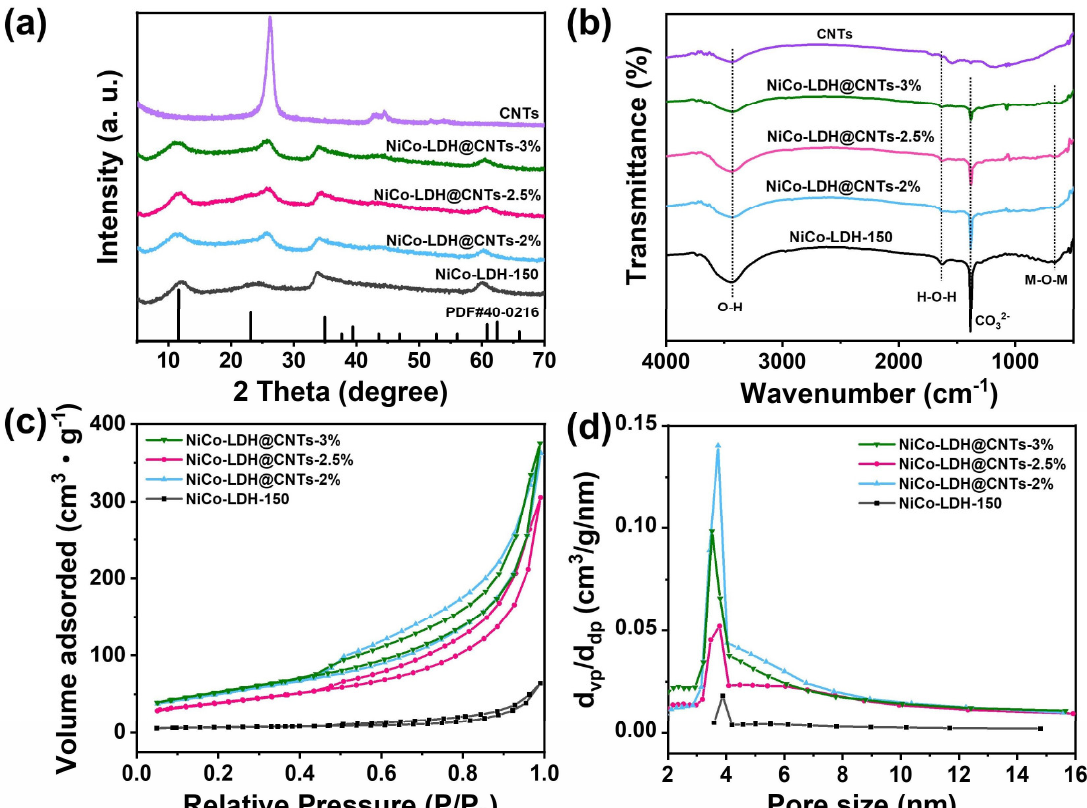
Figure 1. ( a ) XRD patterns and ( b ) FT-IR spectra of NiCo-LDH-150, NiCo-LDH@CNTs- z % ( z = 2, 2.5, and 3), and CNTs, respectively. ( c ) N 2 -adsorption/desorption isotherms and ( d ) pore size distribution of the NiCo-LDH-150 and NiCo-LDH@CNTs- z % ( z = 2, 2.5, and 3), respectively.